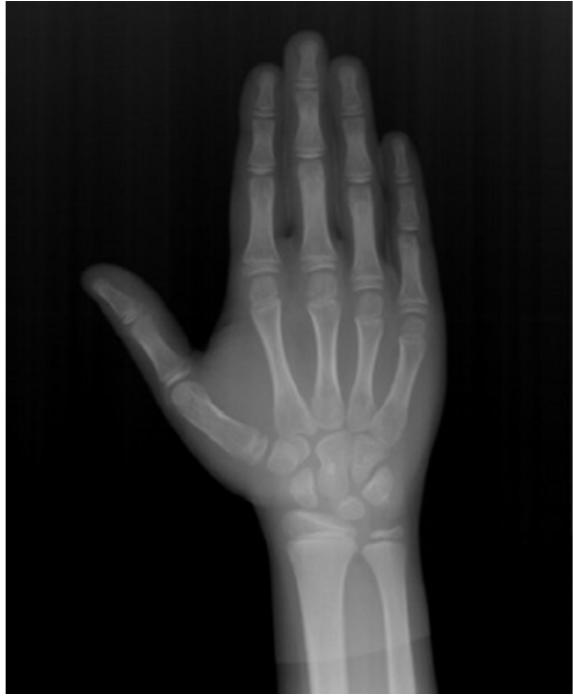
Figure 1. A hand-wrist film of a subject with a UCLP.